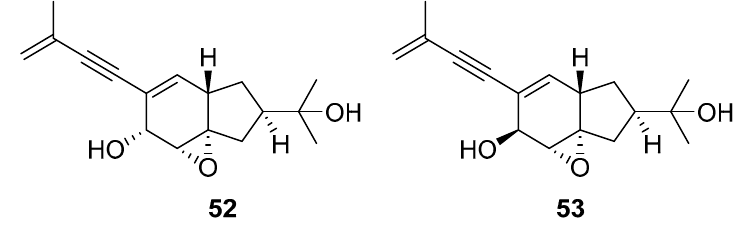
Figure 23. Structures of truncateols O ( 52 ) and P ( 53 ).